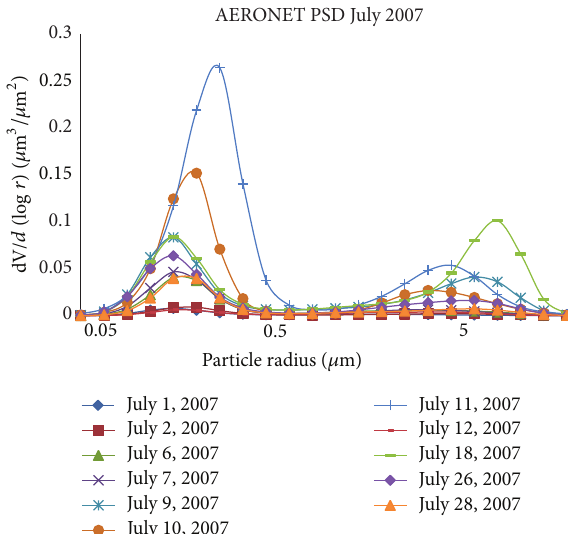
Figure 3: PSD over CCNY AERONET station (40.83N, 73.94W) for July